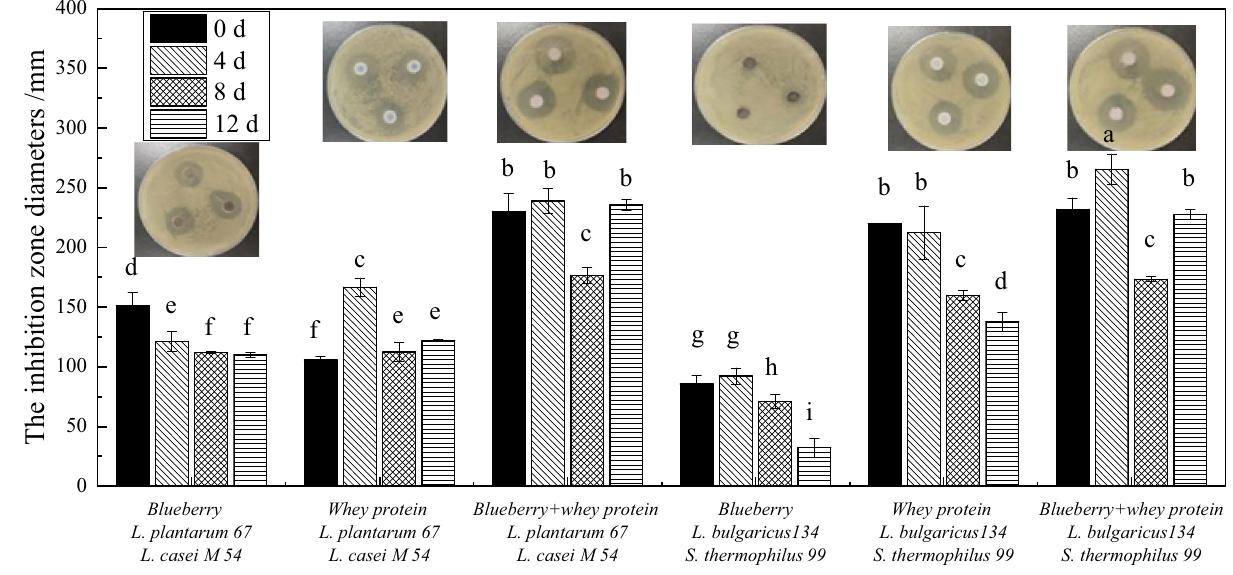
Figure 1. The inhibition zone diameters for whey protein and blueberry juice mixture system fermented with Lactobacillus against E.